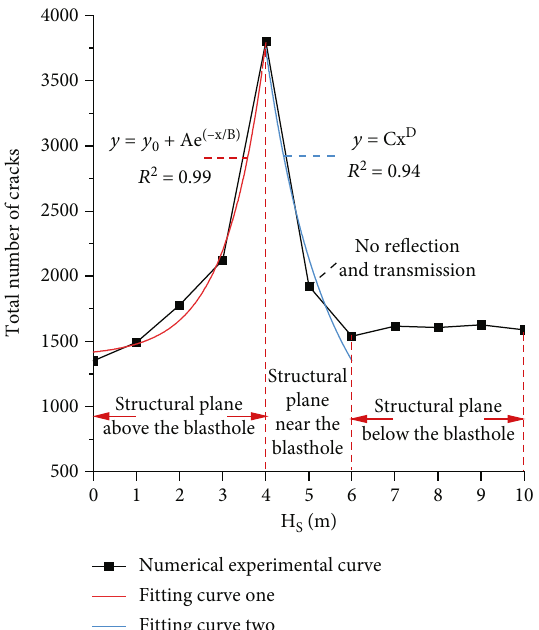
Figure 12: Relationship between H